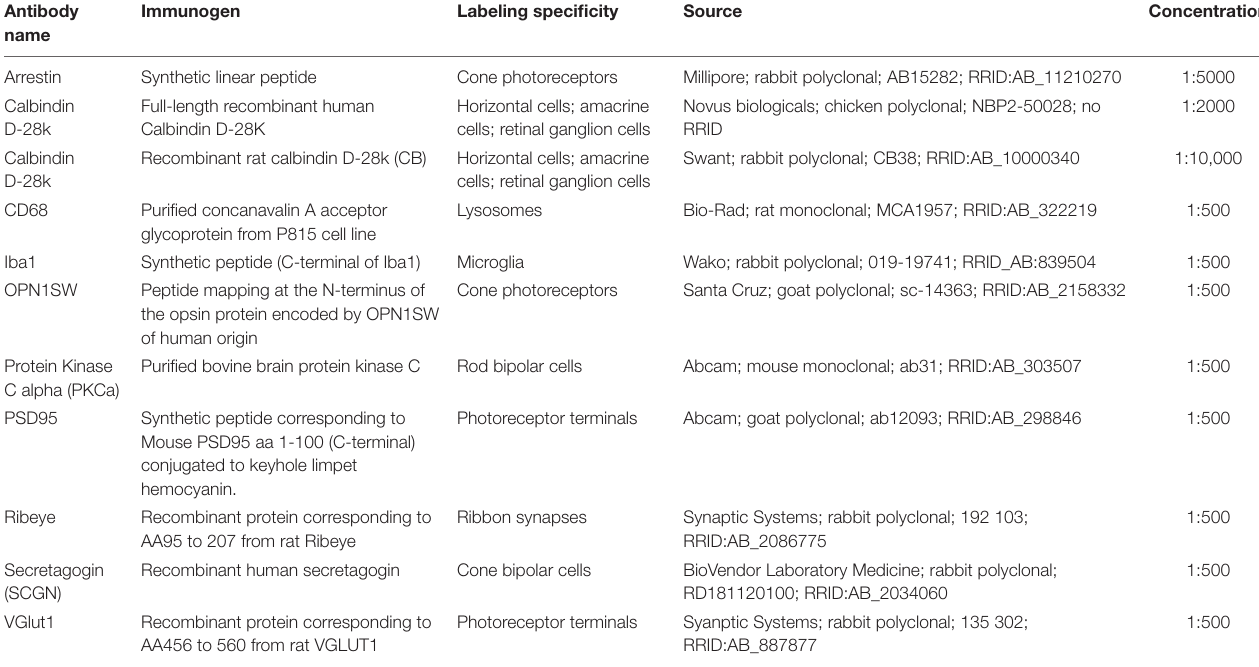
TABLE 1 | Antibodies used in tissue analysis.